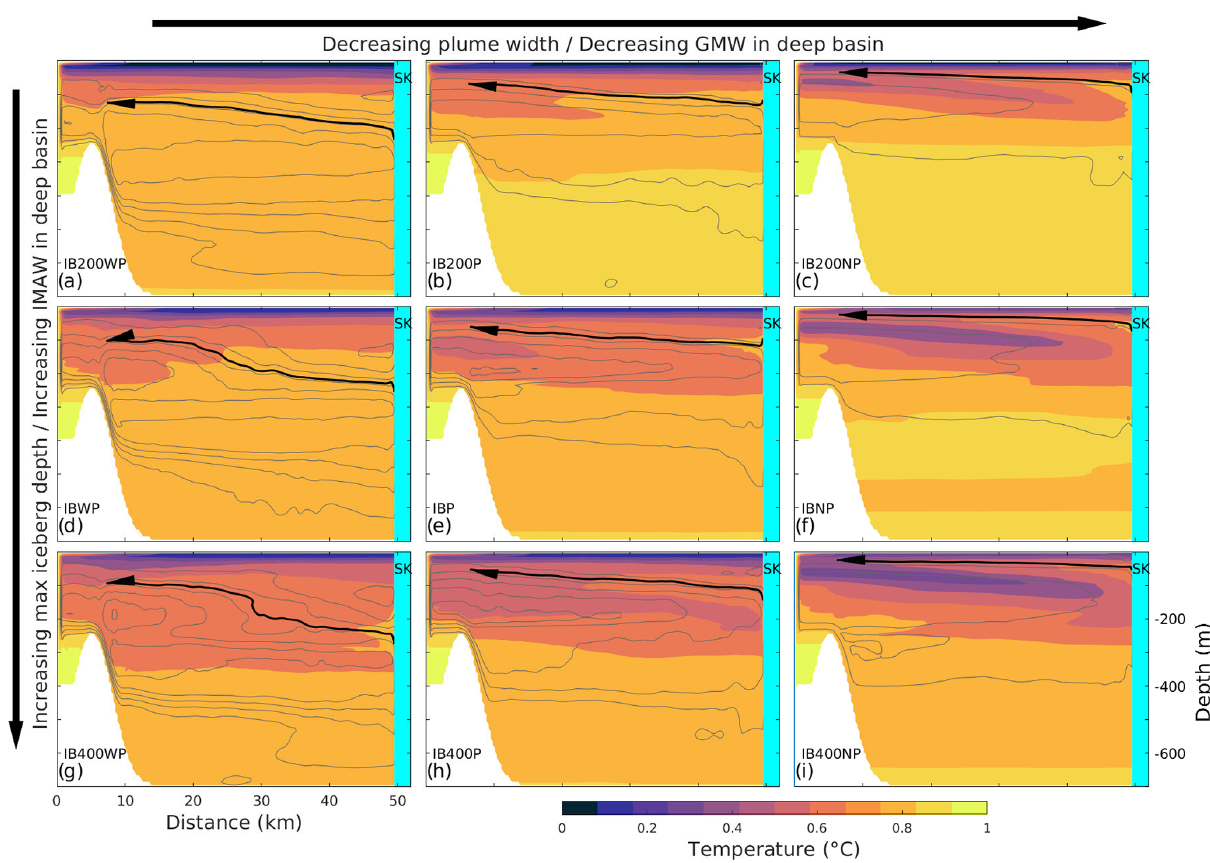
Figure 9. August along-fjord sections of horizontally averaged temperature for all sensitivity experiments with three different plumes (columns) and three different iceberg distributions (rows). See Table 1 for experiment naming. Black arrows indicate the centreline of the GMW outflow from the plume and grey contours a snapshot of streamlines of the horizontal flow rate at 0.02m 3 d − 1